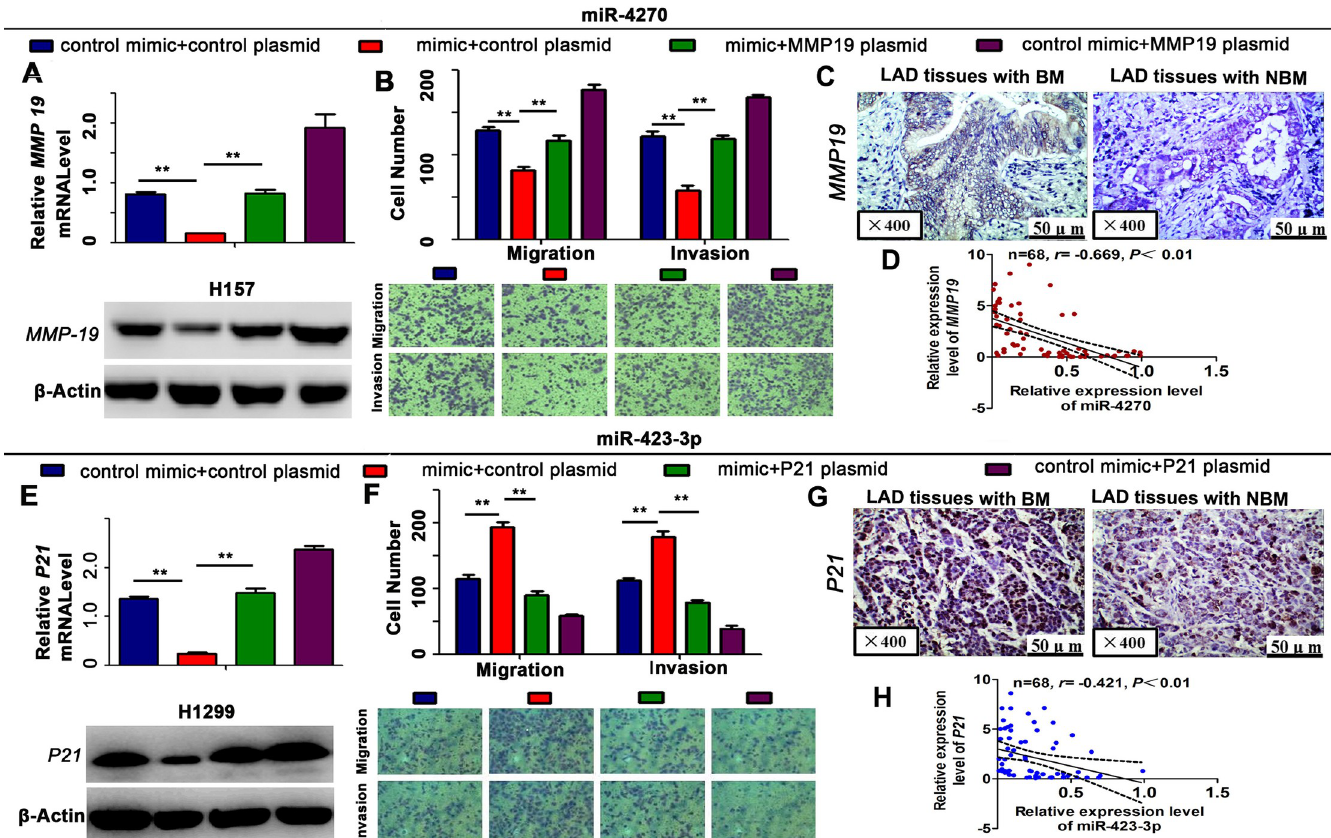
Fig 7. Rescue assay of miR-4270 and miR-423-3p. (A) The mRNA and protein expression levels of MMP-19 . (B) The results of the migration assay after the co- transfection of cells with the miR-4270 mimic and the pEGFP-C1 plasmid containing an MMP-19 CDS sequence. (C) MMP-19 protein expression, as measured by immunohistochemical staining, in LAD samples. (D) Spearman correlation analysis showing the negative correlation between MMP-19 and miR-4270 expression. (E) The mRNA and protein expression levels of P21 . (F) The results of the migration assay after the co-transfection of cells with the miR-423-3p mimic and pEGFP-C1 plasmid containing a P21 CDS sequence. (G) P21 protein expression, as measured by immunohistochemical staining, in LAD samples. (H) Spearman correlation analysis showing the negative correlation between P21 and miR-423-3p expression. Data are presented as the means ± SD of three experiments. �� P < 0.01.